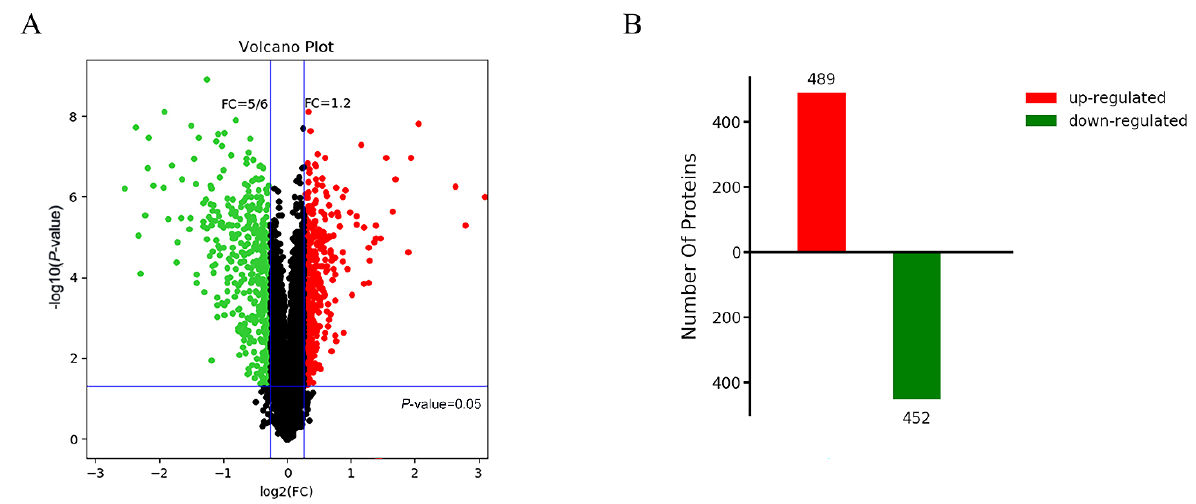
Figure 4. Screening and analysis of differential proteins. ( A ) Volcano map of differential protein distribution; ( B ) bar chart of up- and downregulated proteins.